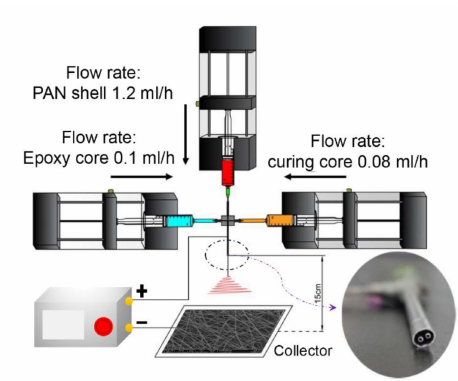
Figure 1. Schematic illustration of the electrospinning polyacrylonitrile (PAN) multiple-chamber nanostructure nanofibers process. The inset shows the internal structure of the homemade spinneret.